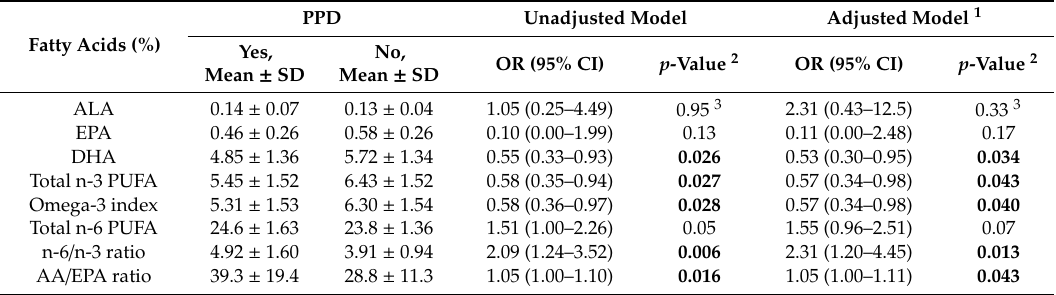
Table 3. Logistic regression model associating postpartum depression with polyunsaturated fatty acids (PUFA) composition (% of total RBC phospholipid FA).